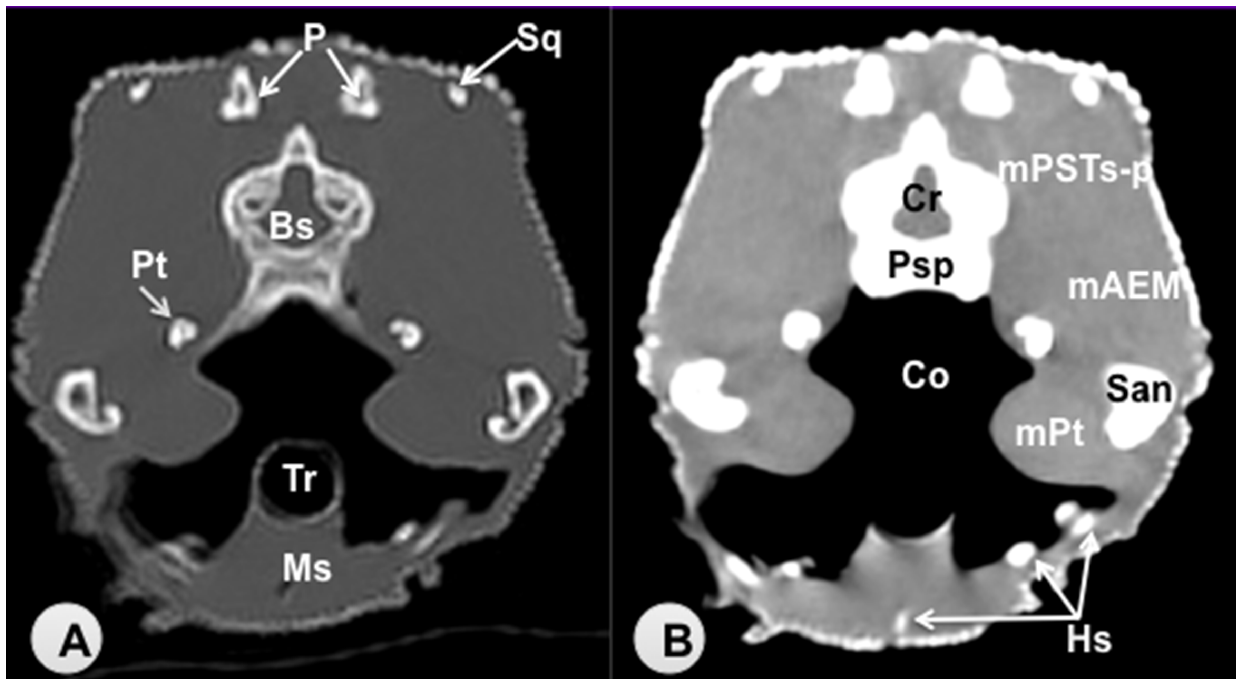
Figure 6. Transverse CT image of the head of Varanus komodoensis at the level of the squamosal bone corrsponding to line VI. ( A ) CT bone window. ( B ) CT soft tissue window. These images are displayed so that the right side of the head is to the viewer’s left and the dorsal view is at the top. Sq: Squamosal bone. P: Parietal bone. Cr: Cerebellum (vermis). Bs: Brain stem. Psp: Parabasisphenoid bone. Pt: Pterygoid bone. San: Surangular bone. Co: Cavum oris. Tr: Trachea. Hs: Hyobranchial skeleton. Ms: Musculus intermandibularis + Musculus geniohyoideus + Musculus hyoglossus. mAEM: Musculus adductor externus mandibularis. mPSTs-p: Musculus pseudotemporalis superficialis and profundus. mPt: Musculus pterygoideus.